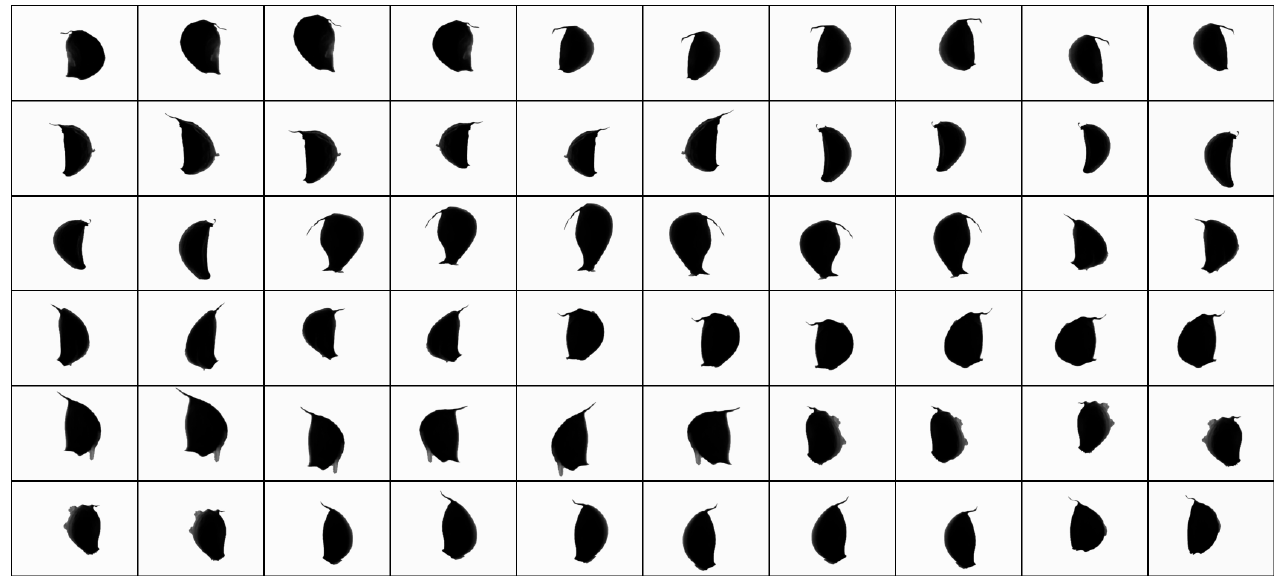
Figure 5. Horizontal reversal amplification sample.